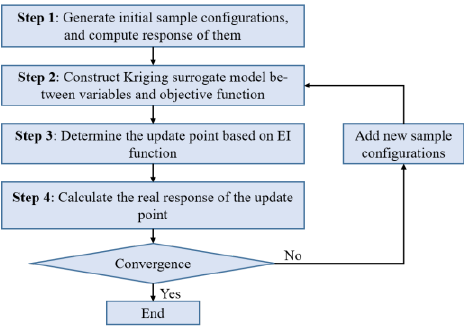
Figure 2. Flowchart of Efficient Global Optimization